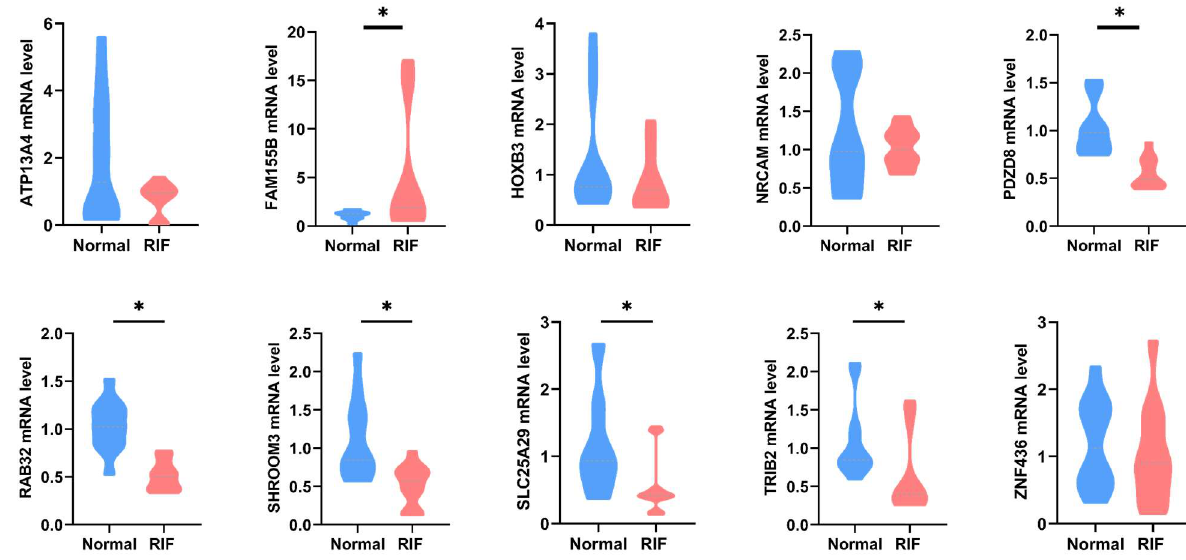
Figure 9. Validation of hub genes in human endometrial tissues. The unpaired Student’s t test was applied. * p < 0.05 indicates significant differences between RIF patients and healthy controls.